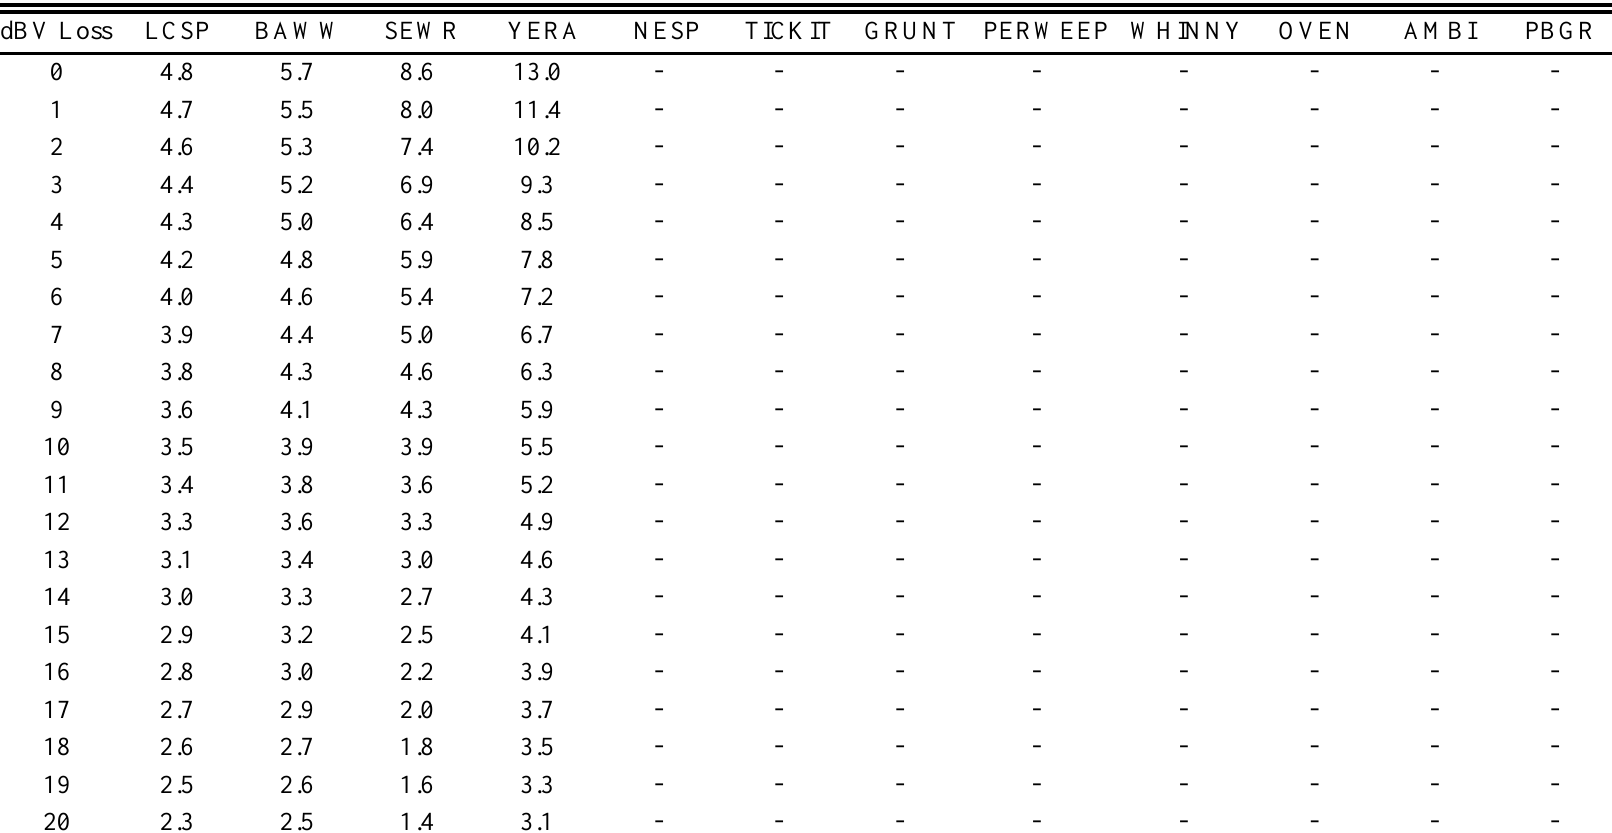
Table A5.1. Effective detection area (ha) of the four call types that did not exceed our experimental range for varying degrees of microphone sensitivity loss and under ambient noise conditions (32